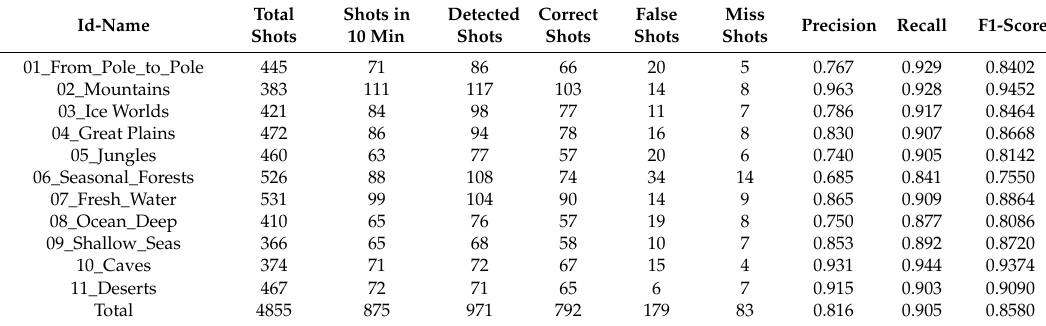
Table 12. The results for the BBC Planet Earth Dataset.